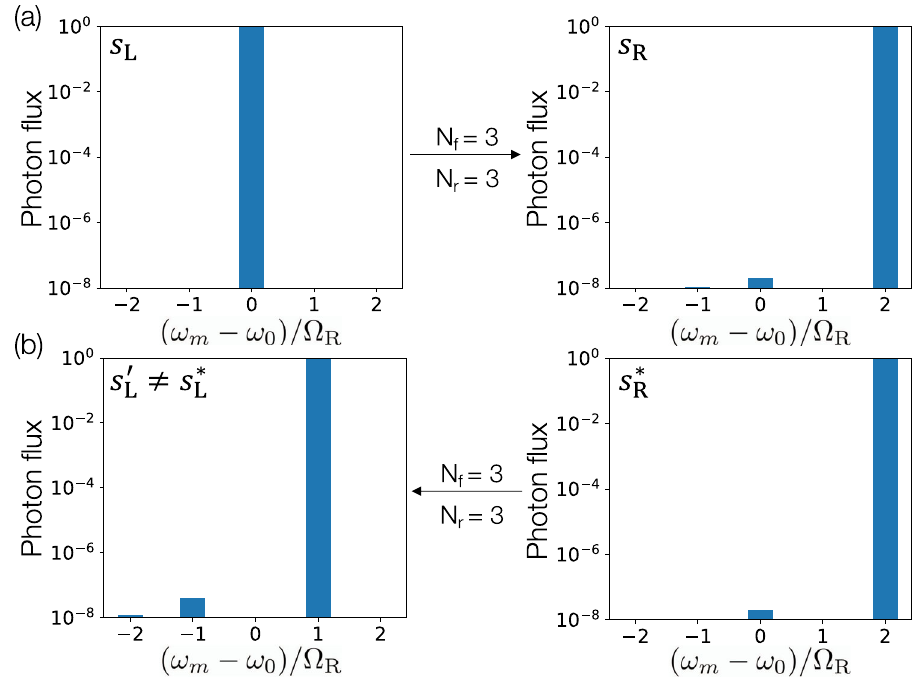
Fig. 3 Nonreciprocal frequency conversion. A three-ring system with three modulation tones per ring, demonstrating a a conversion ef fi ciency exceeding 1 − 10 − 5 from mode 0 to mode + 2 in forward propagation. The input and output fi eld pro fi les are indicated by s L and s R , respectively, and b the complex- conjugated output pro fi le, s (cid:4) R , injected back into the output port results in a conversion ef fi ciency exceeding 1 − 10 − 5 from mode + 2 to + 1 instead of mode 0 in backward propagation through the same system, indicating highly ef fi cient nonreciprocal frequency shifts. Modulation parameters are provided in Supplementary Note 6.